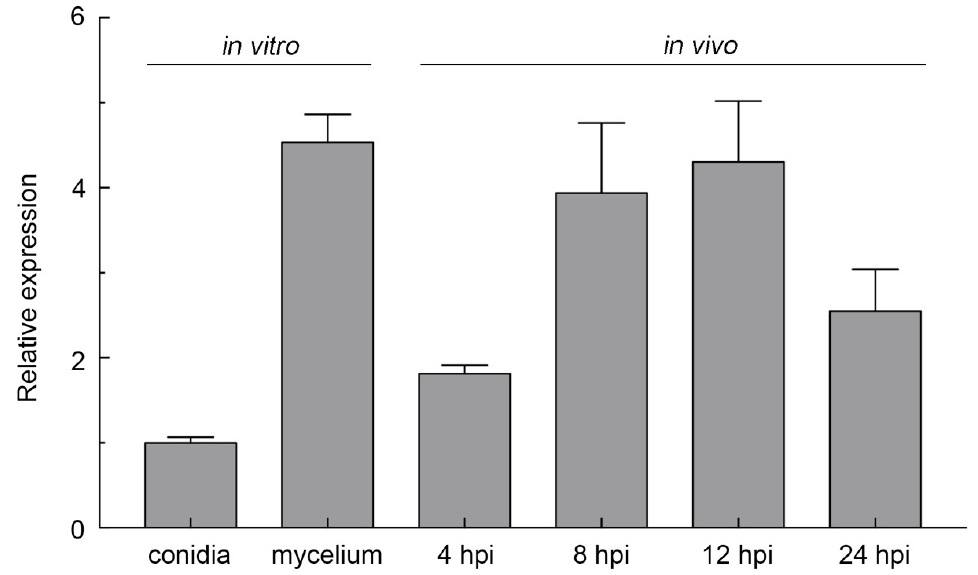
Figure 2. Transcript levels of FocCP1 at different developmental stages. Transcript levels were normalized to the expression of the fungal reference gene EF1 α . Data are the means ± SDs from three independent experiments.